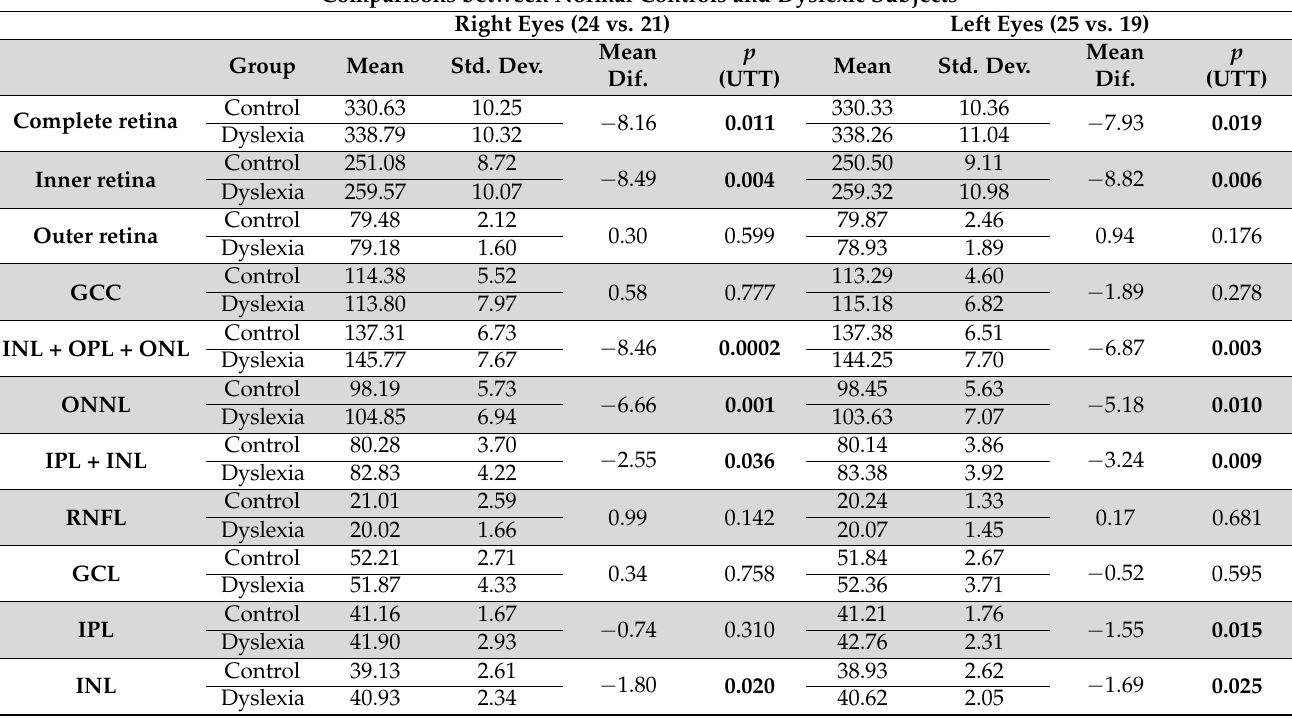
Table 1. Thickness comparison between the groups for the inner ring subfield (parafovea) in the ETDRS grid. Thickness of the Inner ETDRS Ring Subfield (Parafovea) Comparisons between Normal Controls and Dyslexic Subjects Right Eyes (24 vs. 21) Left Eyes (25 vs. 19) Mean Group Mean Std. Dev.